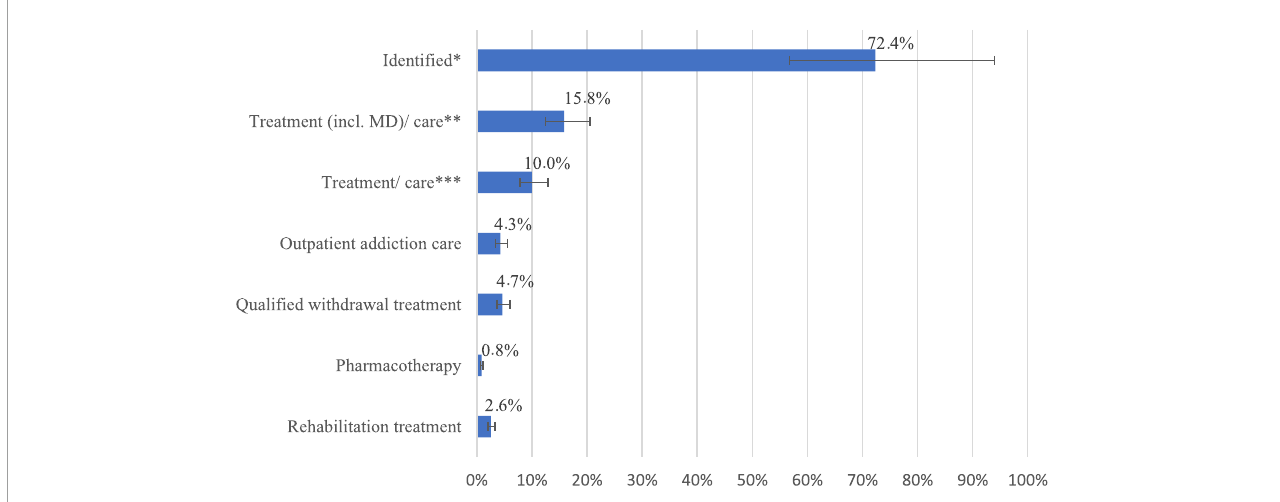
FIGURE2 Diagnoses and specific treatment/care rates of persons with alcohol dependence in Bremen 2016/2017. Proportions of extrapolated treatments in the estimate for persons with alcohol dependence in the total population of Bremen ˆN Bremen 15,792 (12,163–20,120). ∗ Identified includes individuals with